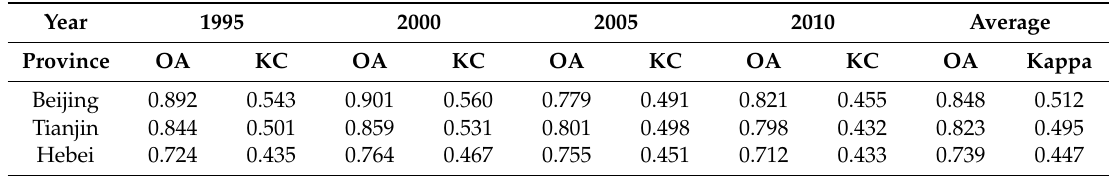
Table 6. Accuracies for di ff erent cities based on